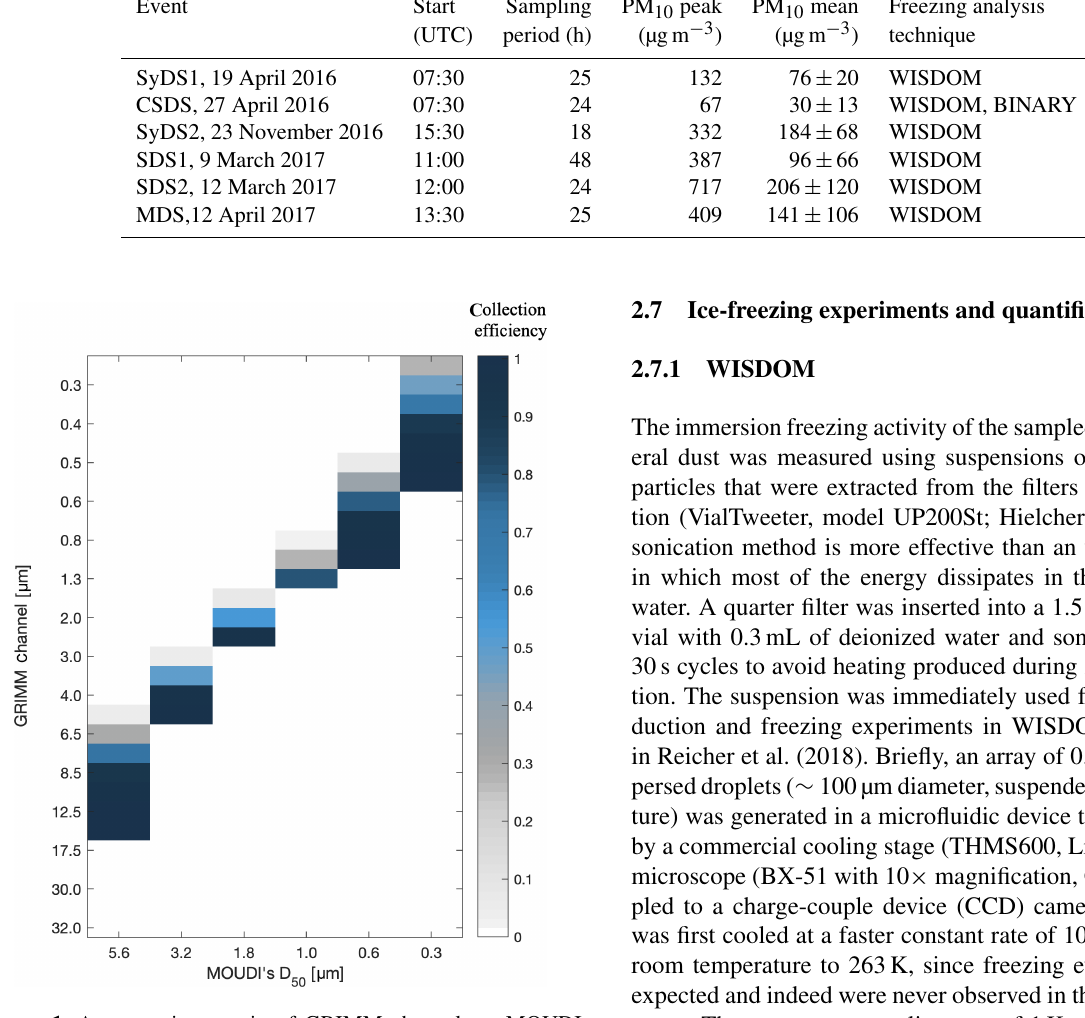
Figure 1. A conversion matrix of GRIMM channels to MOUDI stages. The conversion was based on collection efficiency curves from Marple et al. (1991). The color shades represent the fraction of particles of a specific GRIMM channel to be impacted on a spe- cific MOUDI